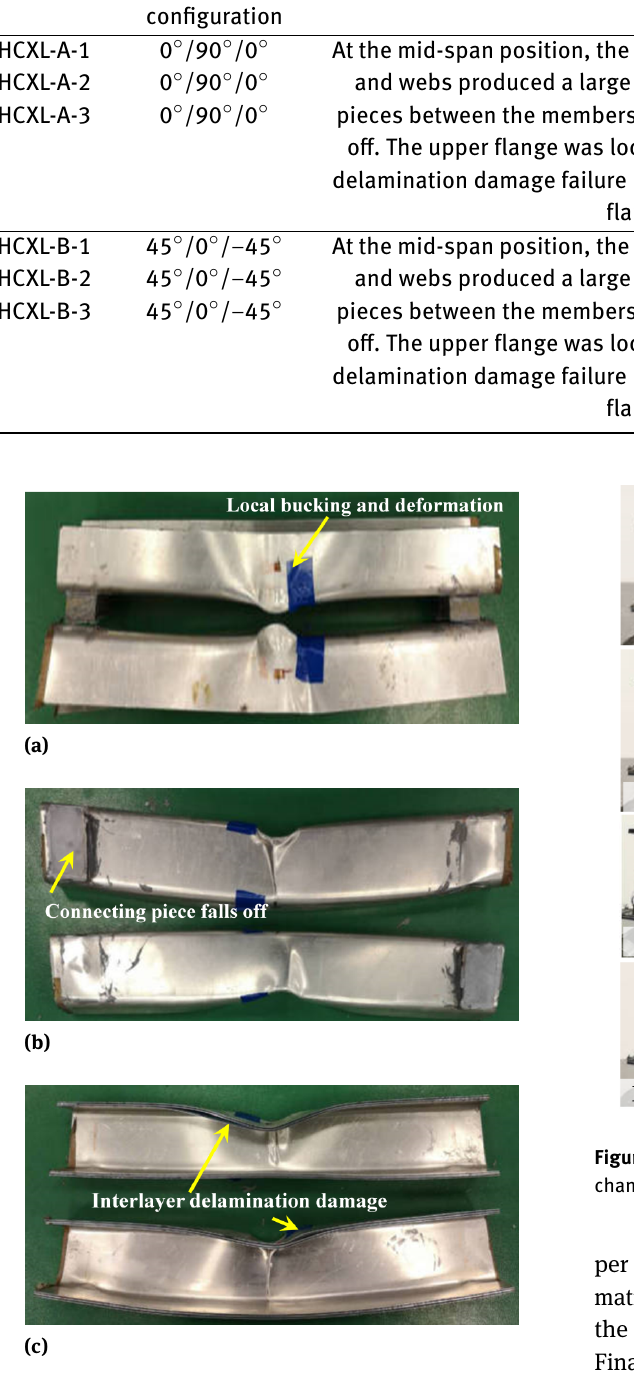
Figure 5: Failure modes of double-channel CARALL beams: (a) Local buckling and deformation of the upper flange and web; (b) connect- ing pieces fall off; and (c) interlayer delamination damage of upper flange.